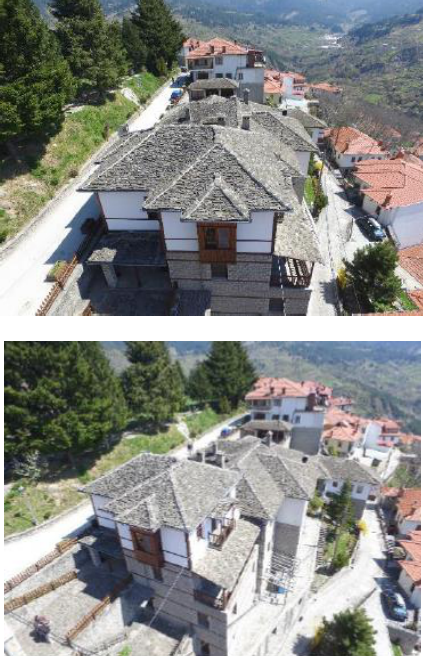
Figure 4: Aerial images of the Averof Museum captured with DJI Phantom 3 Professional